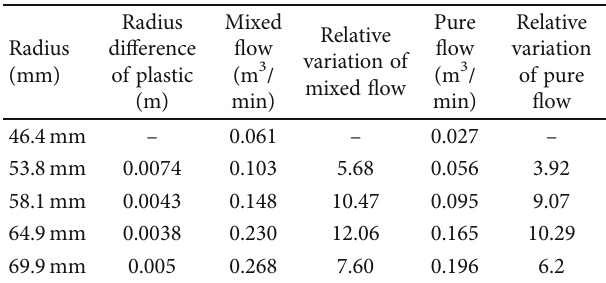
Figure 15: Changes in fl ow and concentration. Table 5: Relative change of the mixed fl ow and pure fl